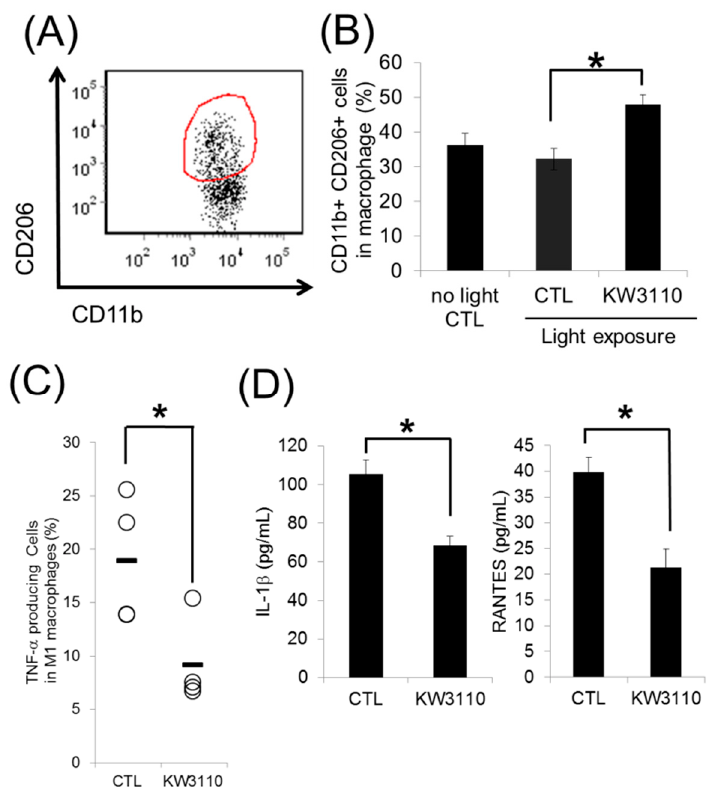
Figure 2. Effect of L. paracasei KW3110 on the induction of M2 macrophage in the retina of a light-exposed mouse model. ( A ) Representative flow cytometry data of CD11b-positive and CD206-positive cells from the blue light-exposed mice fed a diet containing L. paracasei KW3110 (KW3110) or fed a control diet (CTL). ( B ) The ratio of CD11b-positive, f4/80-positive, and CD206-positive M2 macrophage cells to CD11b-positive and f4/80-positive macrophage cells. ( C ) The ratio of TNF- α -producing cells in CD11b-positive M1 macrophage cells. To detect inflammatory cytokine-producing cells, retinal cells were cultured under stimulation with Leukocyte Activation Cocktail plus BD GolgiPlug™ and analyzed by flow cytometry. ( D ) The production of inflammatory cytokines IL-1 β and RANTES in the retinal cell culture medium. CTL, control; KW3110, L. paracasei KW3110; TNF- α , tumor necrosis factor- α ; IL-1 β , interleukin-1 β ; RANTES, regulated on activation, normal T cell expressed and secreted. Values are presented as the mean ± SEM. Significance was assumed if the p value was < 0.05. * p < 0.05.